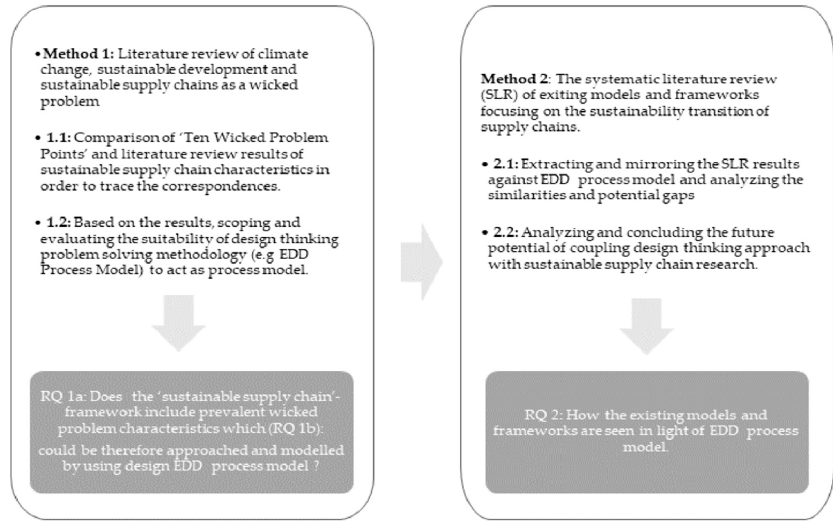
Figure 1. Summarised research flowchart.